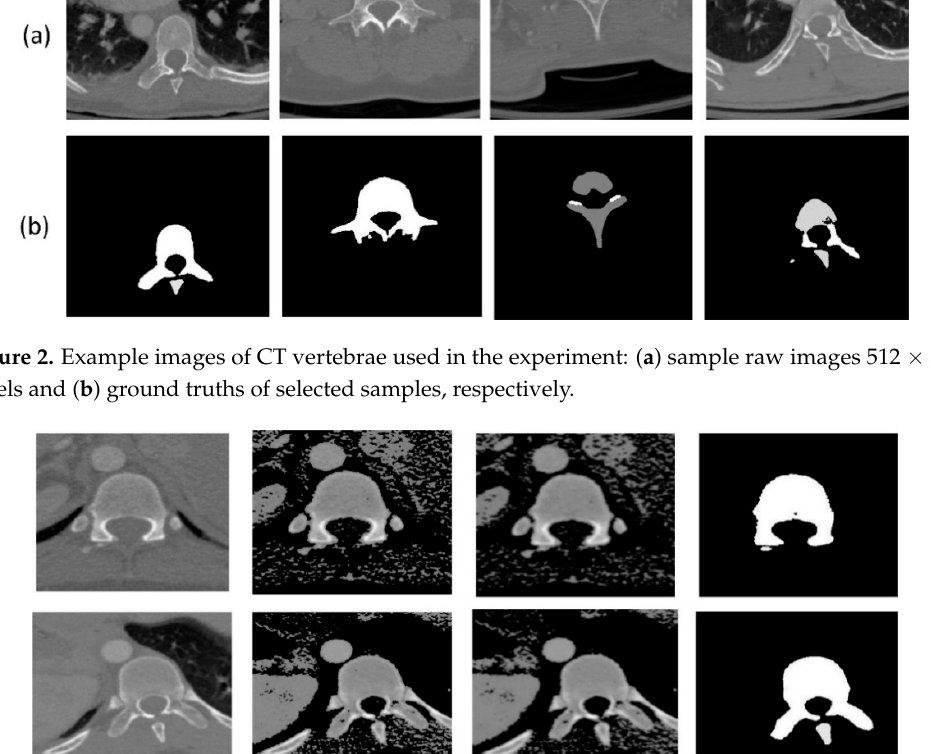
Figure 3. Preprocessing phase: ( a ) ROIs by cropping the images using a bounding box; ( b ) applying threshold window; ( c ) Gaussian smoothing filter; and ( d ) respective ground truths.